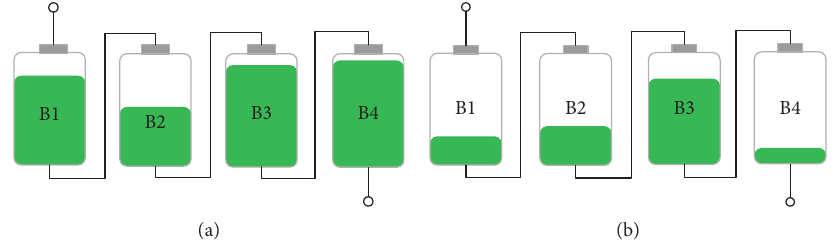
Figure 8: (a) Imbalanced SOC with one cell of low SOC and others of high SOC; (b) imbalanced SOC with one cell of high SOC and others of low SOC.